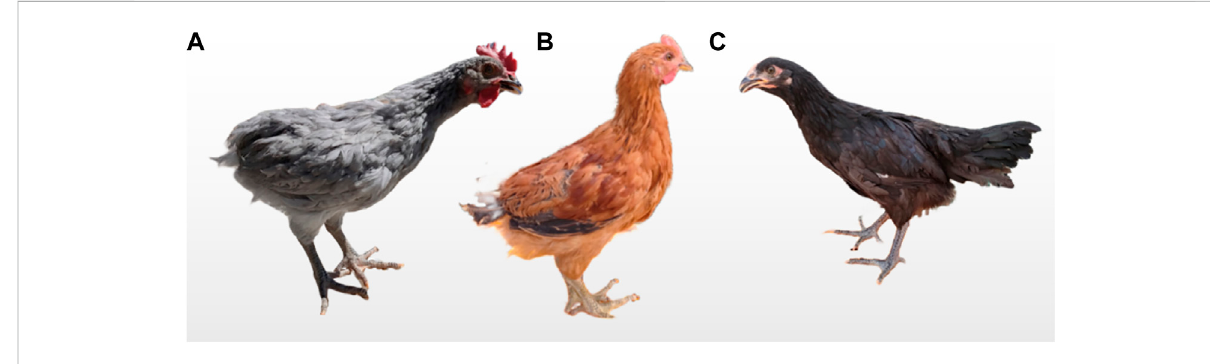
FIGURE 1 Baicheng You chicken with black (C) , yellow (B) , and lavender (A) feather